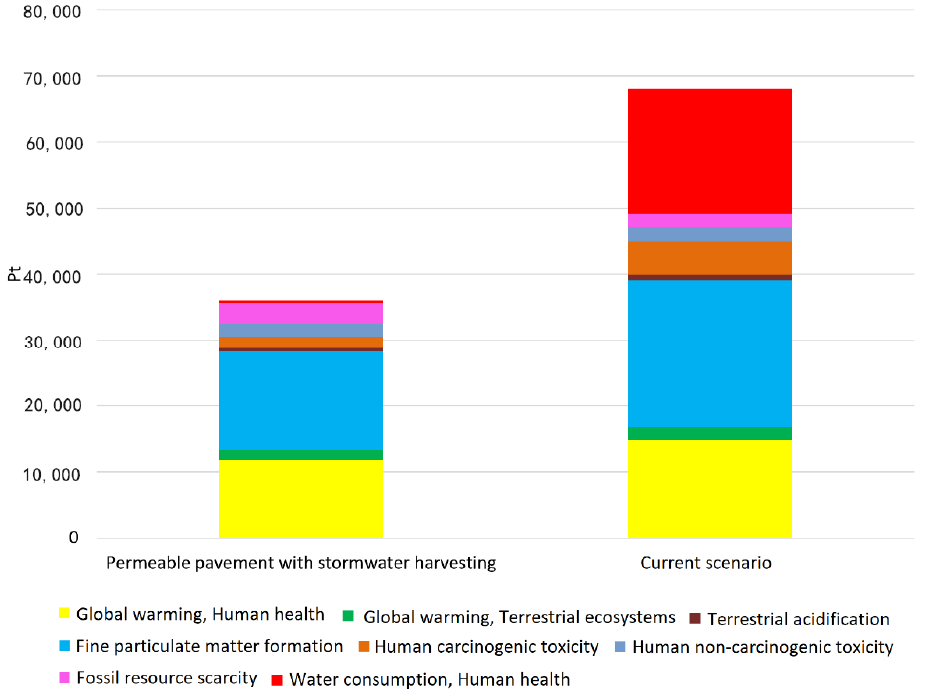
Figure 6. Comparison of scenarios using the ReCiPe endpoint method (single score).